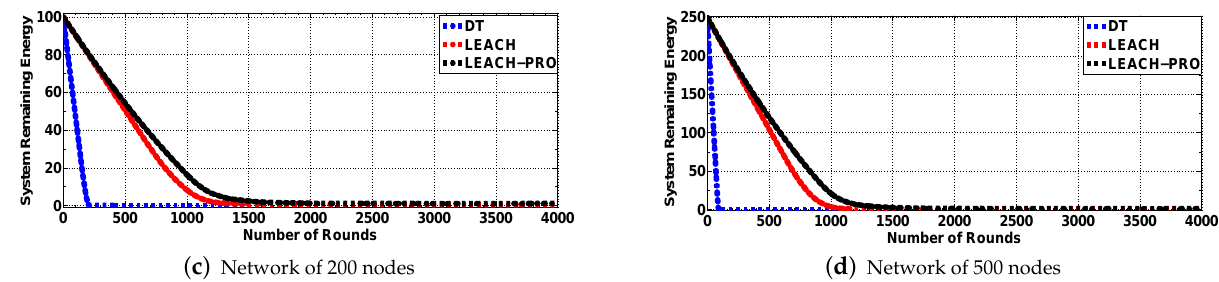
( c ) Network of 200 nodes ( d ) Network of 500 nodes Figure 13. System residual energy under varying network densities. Network of ( a ) 50, ( b ) 100, ( c ) 200, ( d ) 500 nodes.